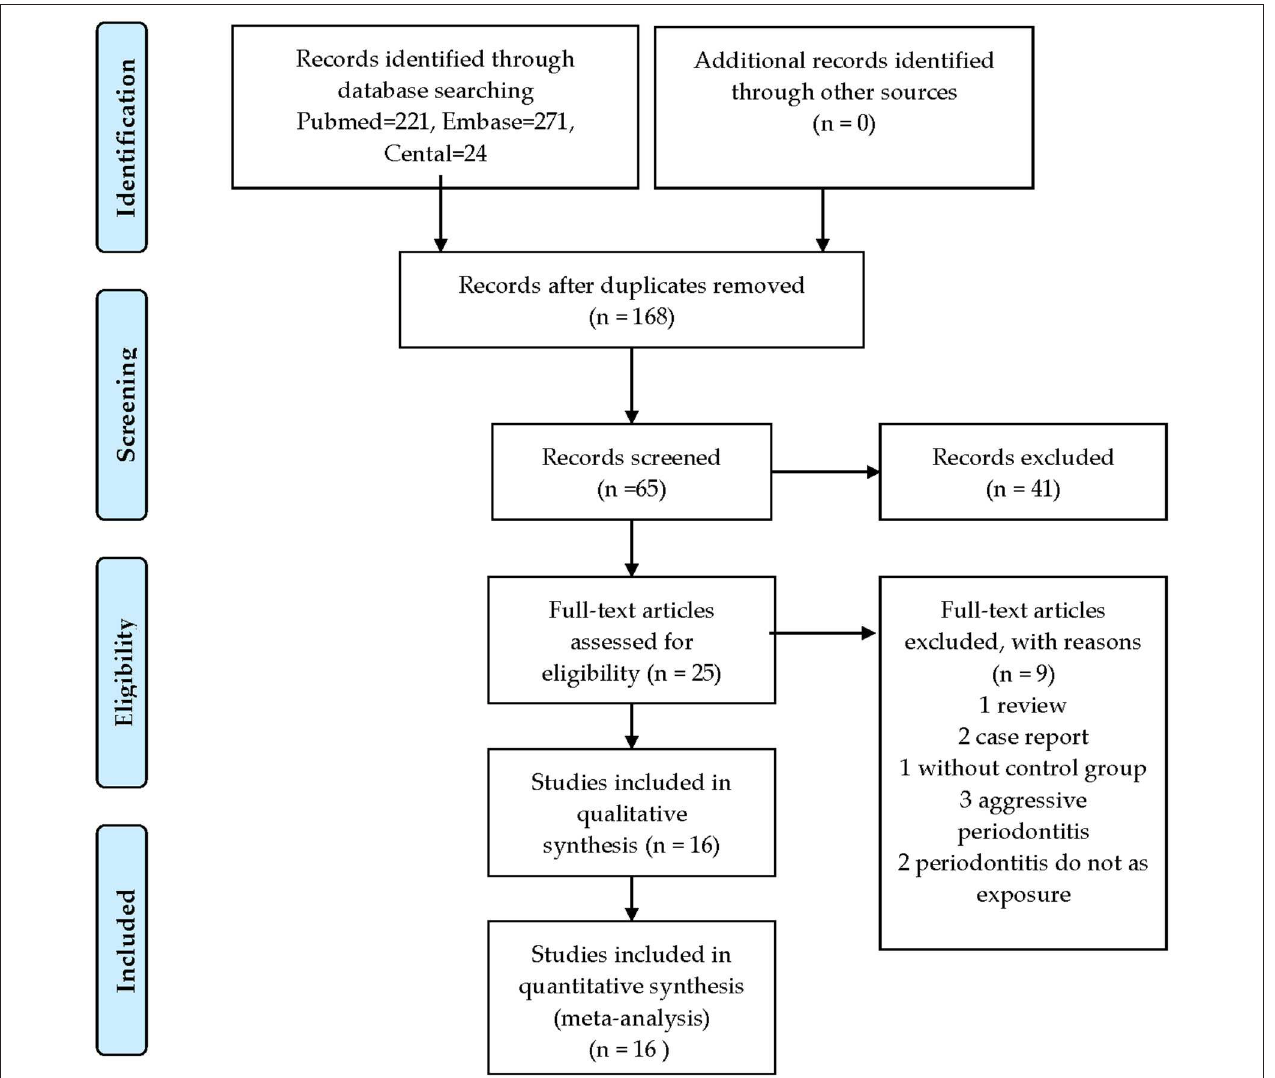
FIGURE 1 | Flow diagram of study